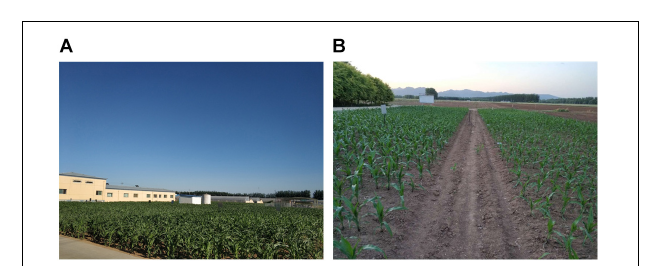
FIGURE 3 | Two experimental parcels. (A) Is parcel-1; (B) is